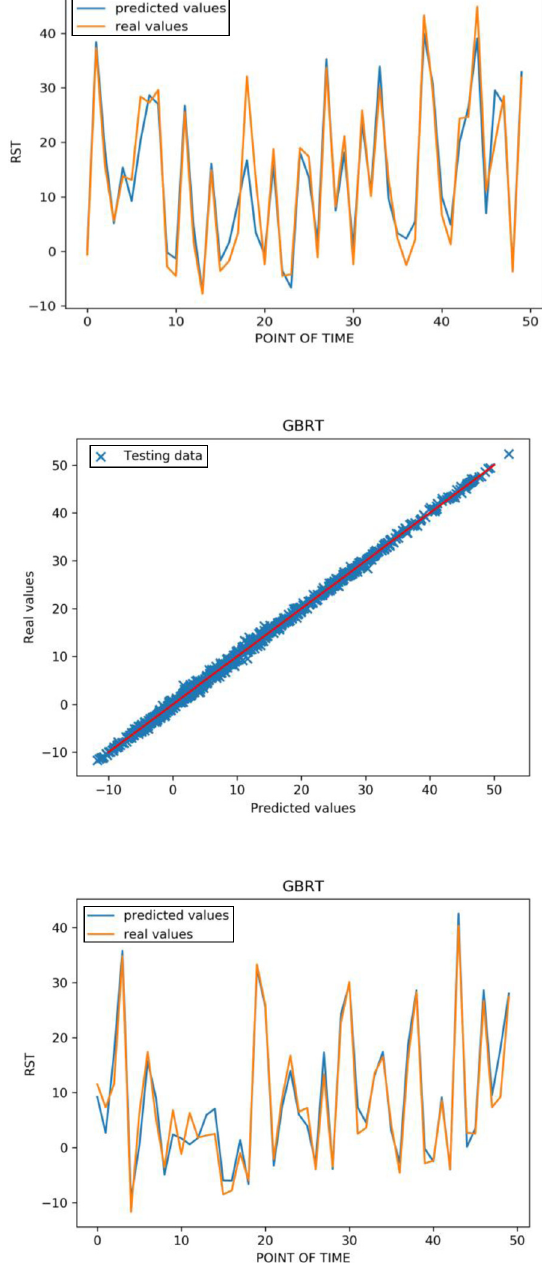
Figure 10. Line chart of real value and predicted value with